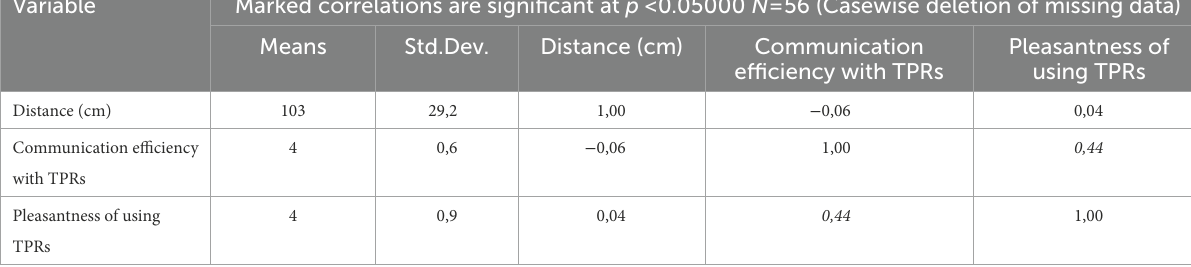
TABLE 5 Correlations between the communication efficiency and pleasantness when using telepresence robots.